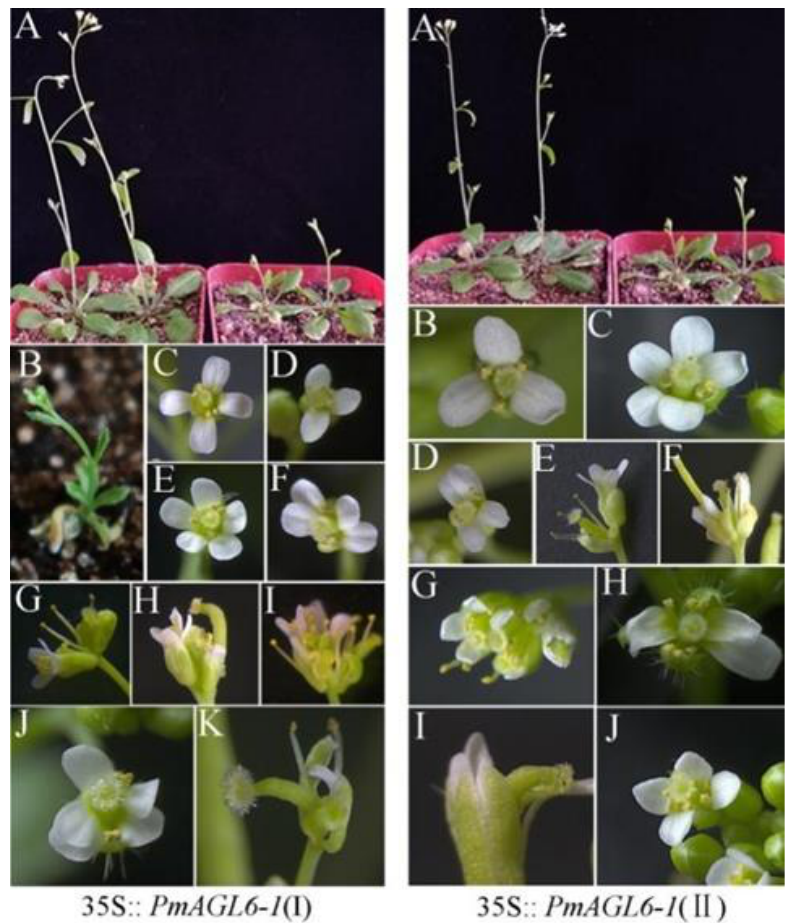
Figure 4. Functional analysis of PmAGL6-1 and PmAGL6-2 by transforming Arabidopsis plants. ( IA – IK ) Constitutive expression in 35S:: PmAGL6-1 transgenic Arabidopsis plants. ( IIA – IIJ ) Constitutive expression in 35S:: PmAGL6-2 transgenic Arabidopsis plants. ( IA ) Early-flowering phenotype (A4 line) following the ectopic expression of PmAGL6-1 (left) and normal vegetative growth in the wild- type (right). ( IIA ) Early-flowering phenotype (B4 line) following the ectopic expression of PmAGL6- 2 (left) and normal vegetative growth in the wild-type (right). ( IB ) Extremely early-flowering phe- notype (A1 line) following the ectopic expression of PmAGL6-1 . ( IC ) Flower from wild-type Ara-